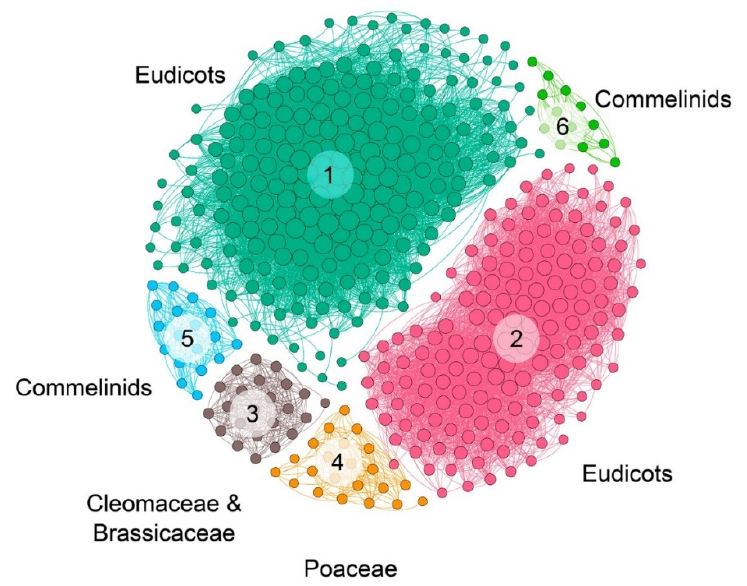
Figure 4. NRT2 microsyntenic gene network of the six main communities found in plant. The size of each node corresponds to the number of genes each community contains (larger nodes have more connections). The different communities are colored and labeled.